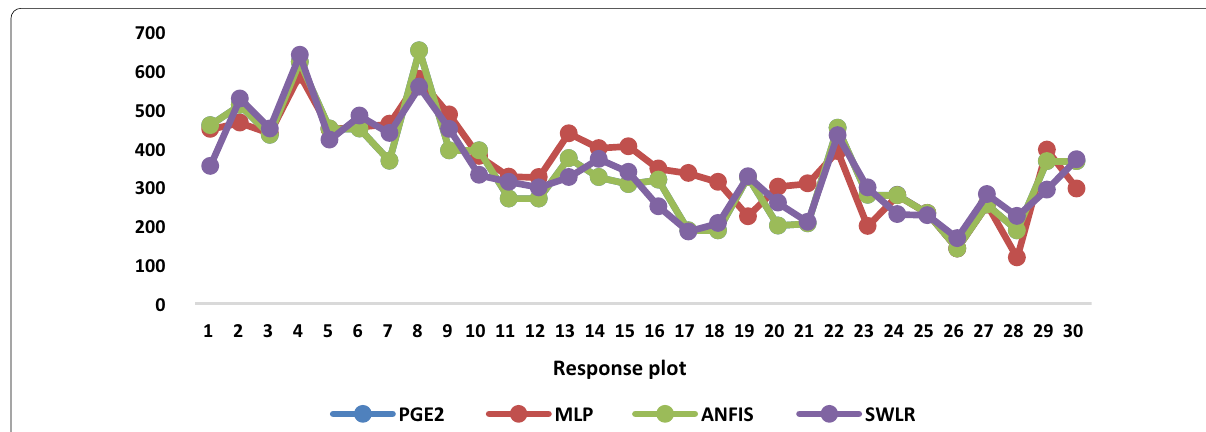
Fig. 7 Comparative performance of the models using the response plot in modelling PGE2 inflammatory